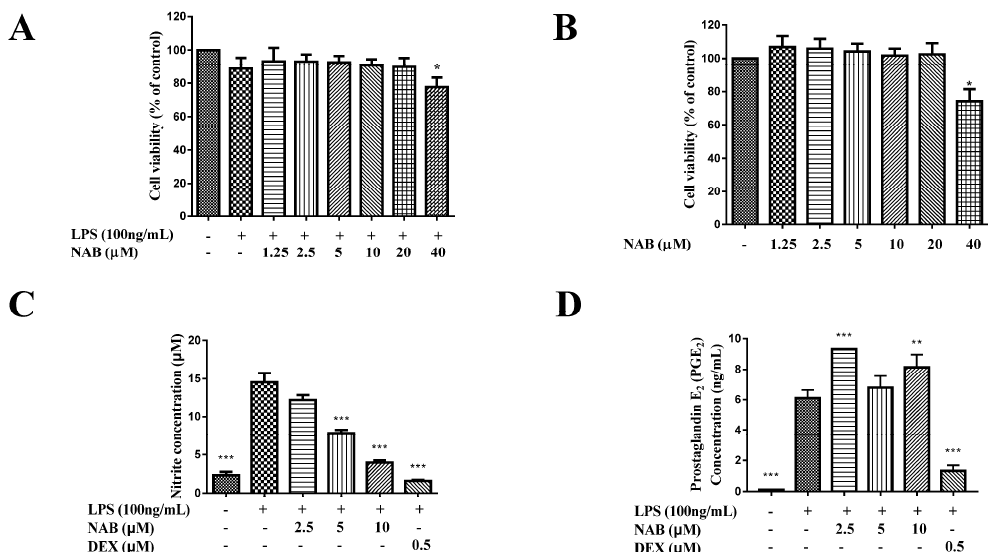
Figure 2. The effect of NAB on the release of nitric oxide (NO) and prostaglandin E 2 (PGE 2 ) in lipopolysaccharide (LPS)-induced RAW264.7 macrophages. ( A ) Cytotoxicity of NAB to LPS-